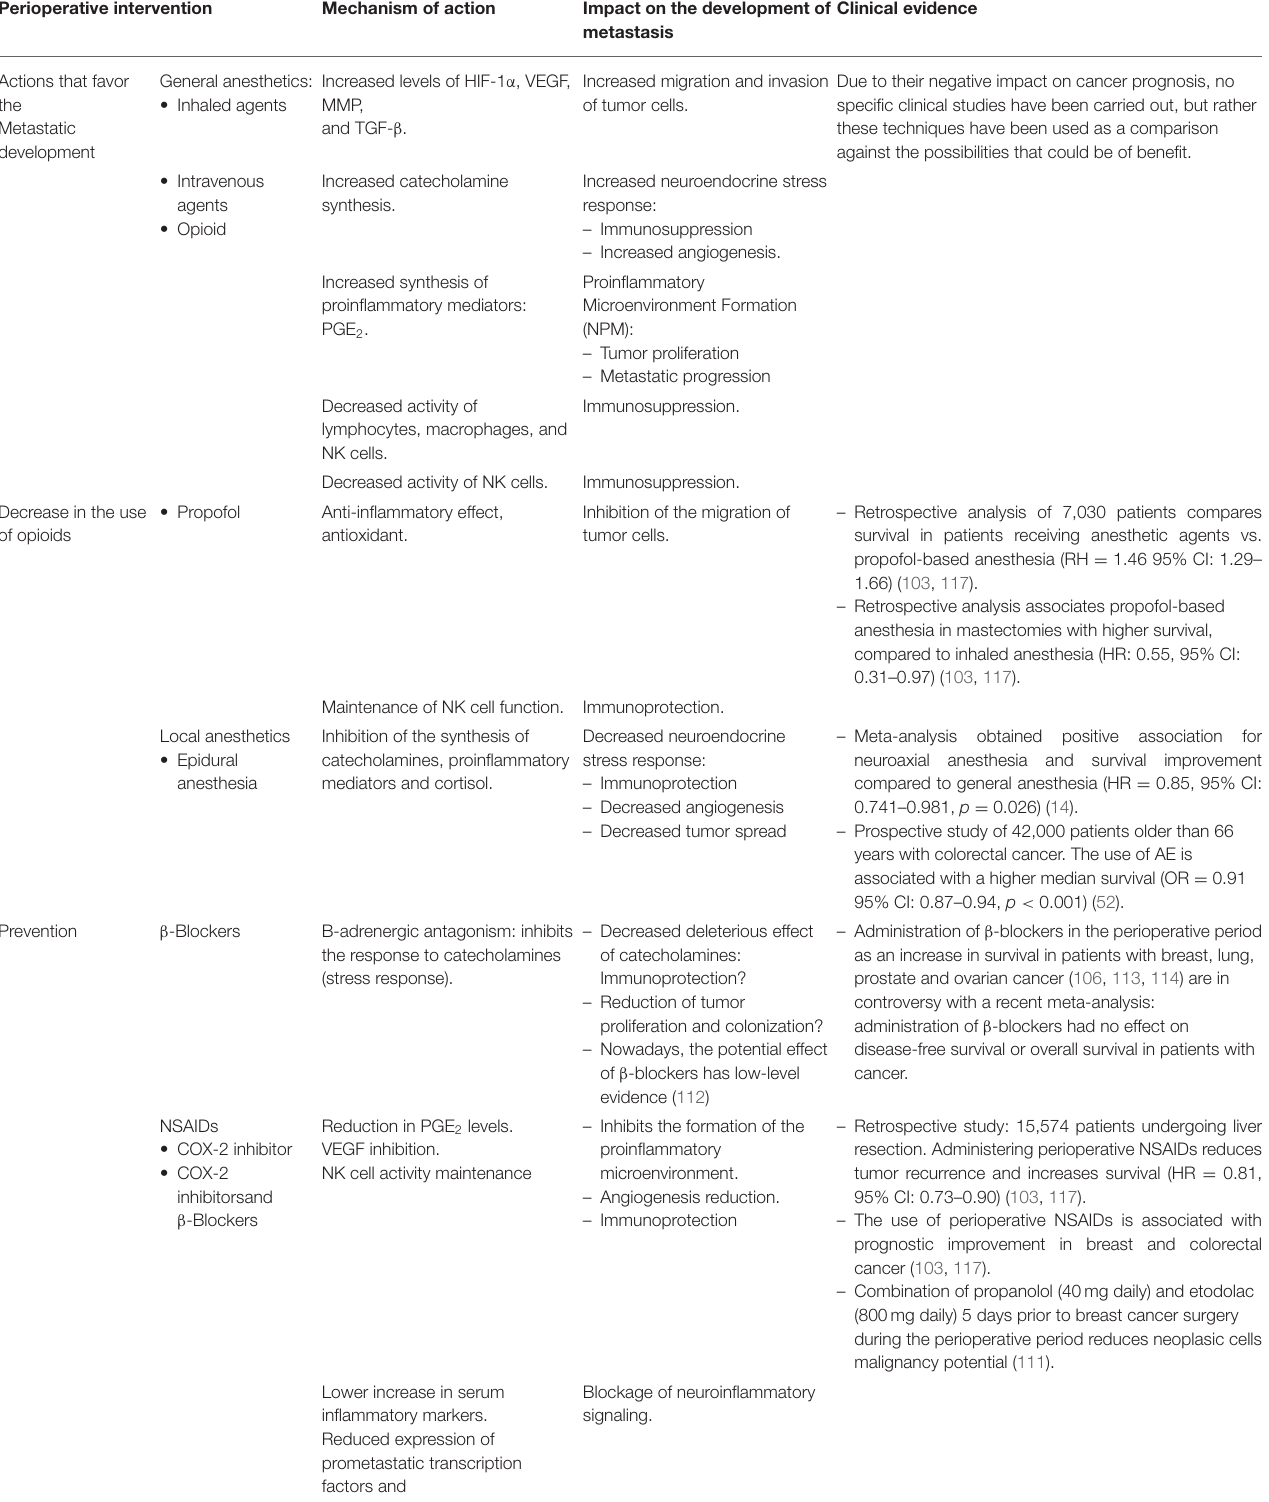
TABLE 3 | Preclinical and clinical studies provide considerable evidence of how agents with antiadrenergic or anti-inflammatory properties, along with other specific anesthetic techniques, could have beneficial effects as possible perioperatory strategy. Perioperative